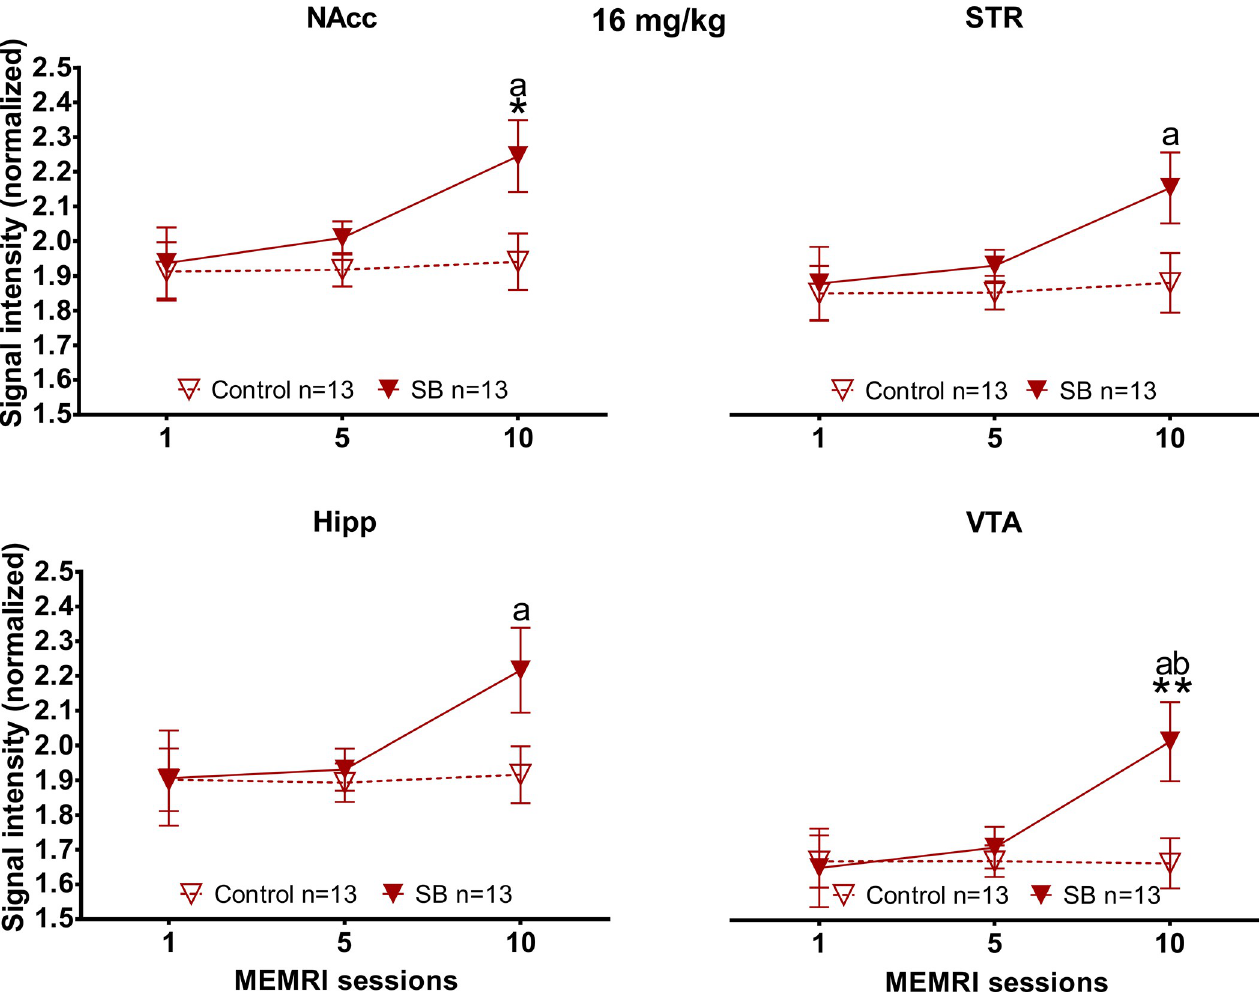
Fig 8. Signal intensity in the nucleus accumbens (NAcc), the striatum (STR), the hippocampus (Hipp) and the ventral tegmental area (VTA) after the females paced the sexual interaction in subjects treated with 16 mg/kg of MnCl 2 . Data are expressed as mean ± SEM. � Different from control, p < 0.05; �� , p < 0.01. a Different form session 1, p < 0.05. b Different form session 5, p <